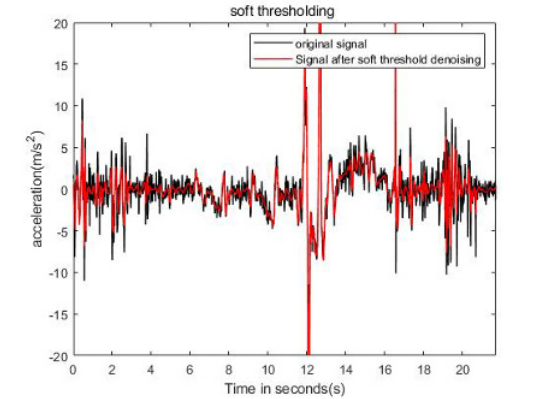
Fig. 3. Figure with signal data processed by soft threshold function.